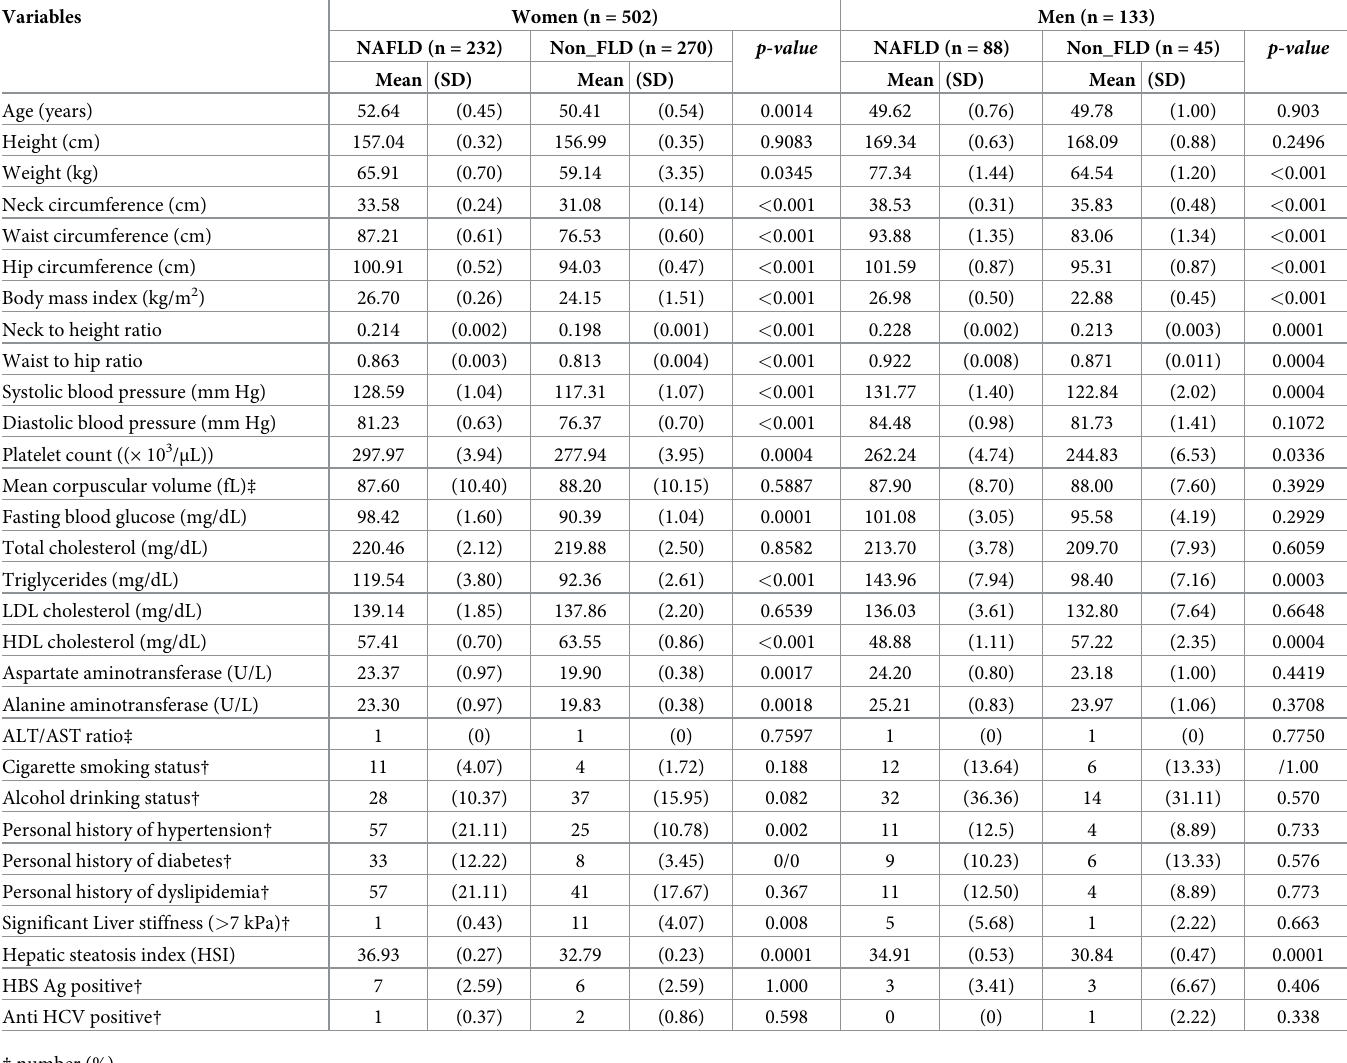
Table 1. Comparison between participants with and without NAFLD, stratified by